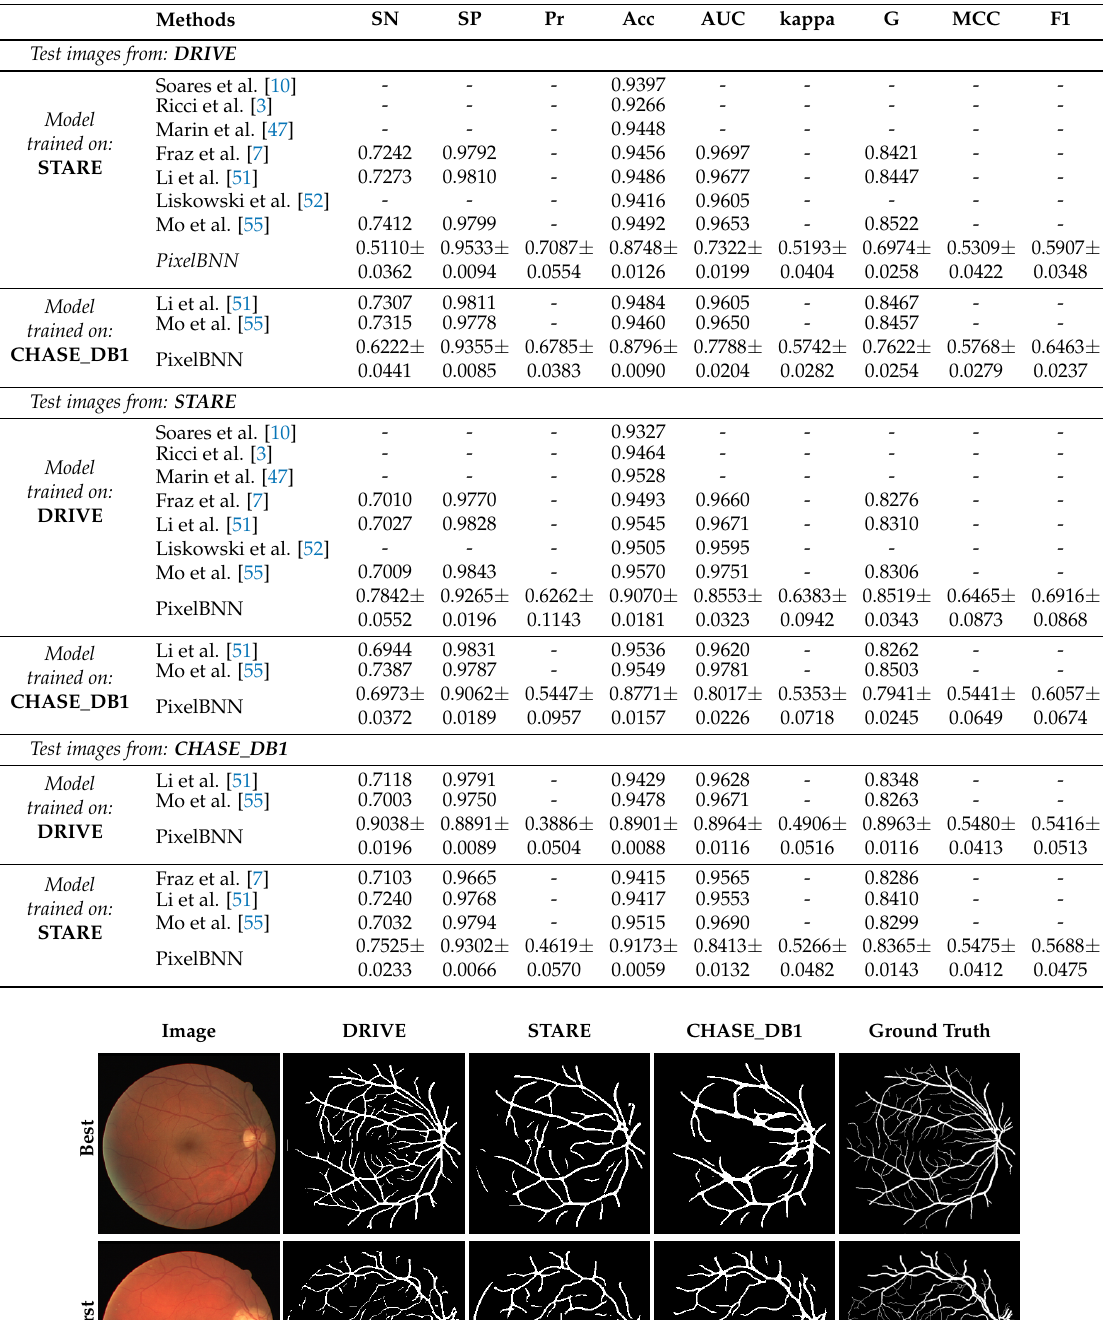
Table 6. Model performance measures from cross-training.